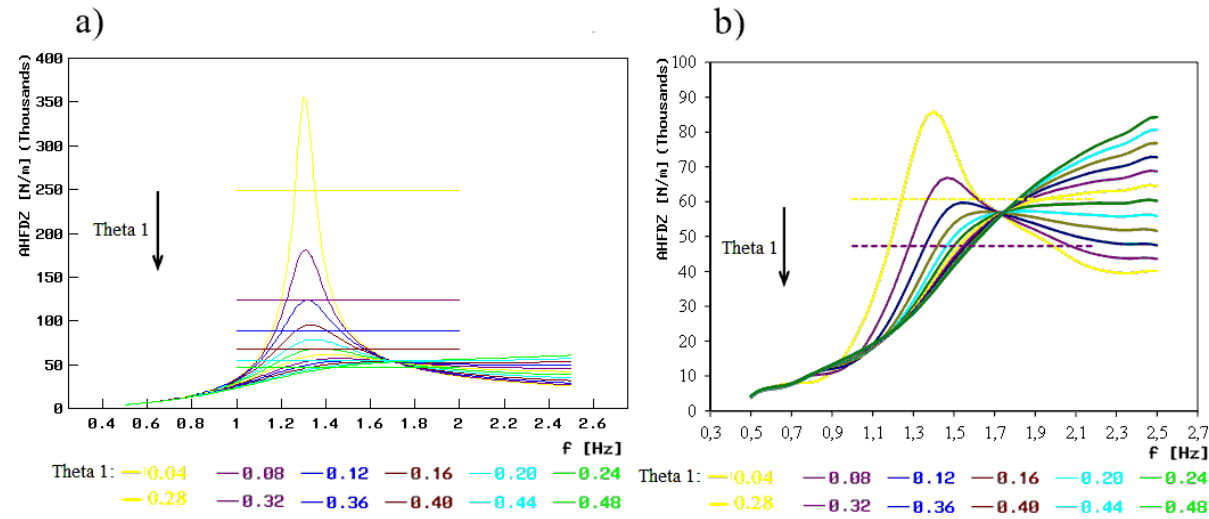
Figure 3: Factors of gain (AHFDZ) in the vertical force at the tire-exciter contact point (relative to the input force) close to the first natural frequency of the front “quarter car” for various damping values ϑ 1 (Theta1): The horizontal lines represent the values of AHFDZ max / a) results for the linear model; b) results for the nonlinear model